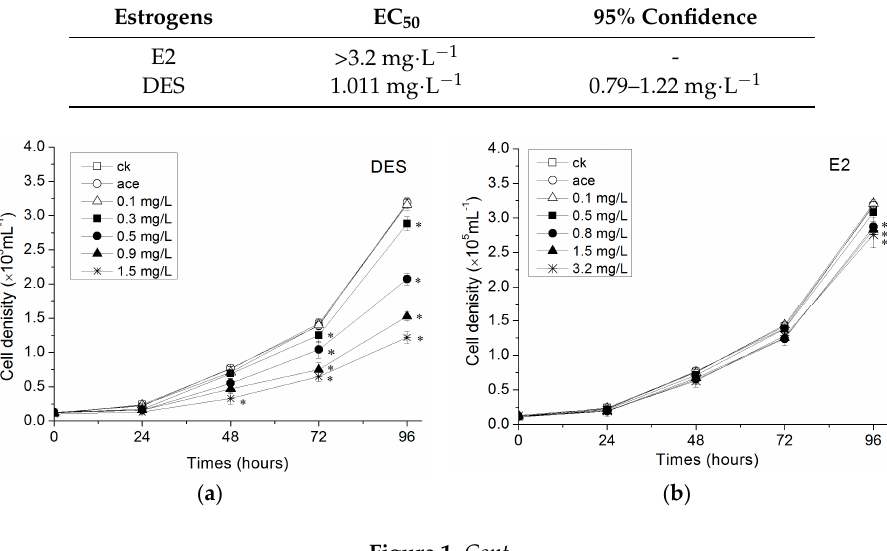
Table 1. The toxicity of estrogens to R. subcapitata (96 h growth inhibition).